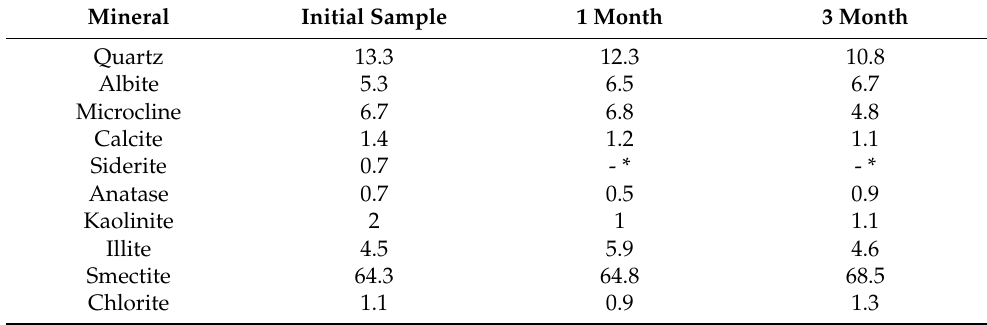
Table 6. Mineral composition of examined samples, determined by the Rietveld approach (wt%).